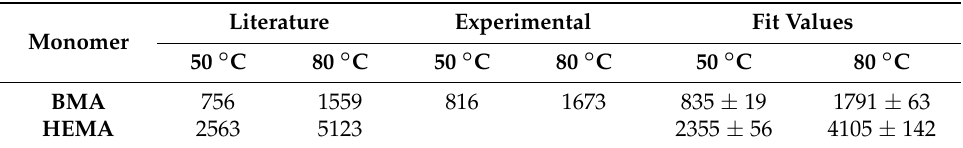
Table 3. A comparison of BMA and HEMA homopolymerization k p (L/mol s) values in bulk taken from literature [5,10], experimentally determined in this study (BMA only), and estimated (with 95% confidence intervals) according to the terminal model (Equation (5)) with r HEMA = 2.27 and r BMA = 0.66.